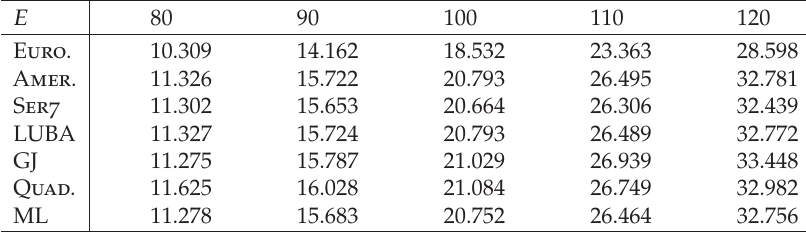
Table 2.12 . Put: Comparison with other methods; as in Table 2.11 but τ = 3 .